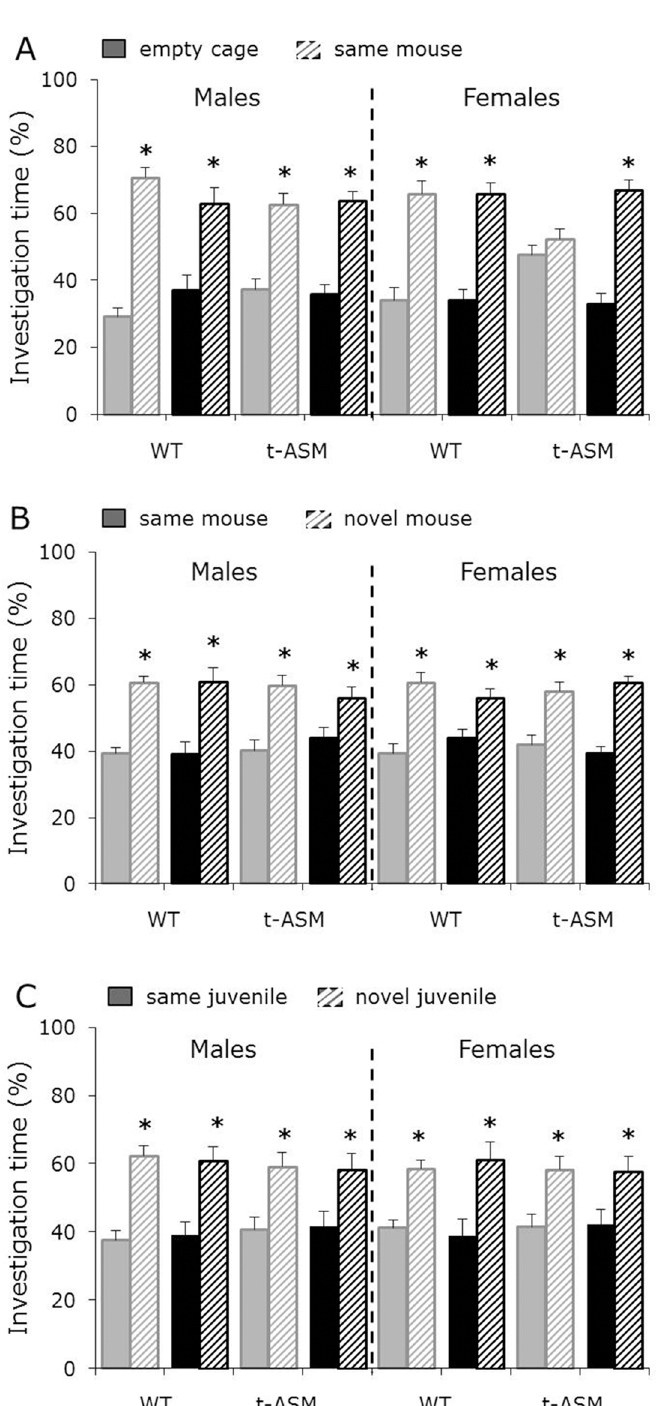
Fig 1. ASM overexpression impaired social preference (A) without altering preference for social novelty (B) or social memory (C) in female, but not in male, mice. Percentage investigation of the empty cage, the same and the novel mouse/juvenile during the first (A) and second (B) 5 min of the social approach test (n = 10 – 13 per group) and during the discrimination period of the social discrimination test (C; n = 6 per group). Mice were treated with amitriptyline (black bars) or water (grey bars) for 4 weeks before and during behavioral testing. Social preference is reflected by higher investigation time directed towards the same mouse versus the empty cage (A). Preference for social novelty (B) and social discrimination (C),